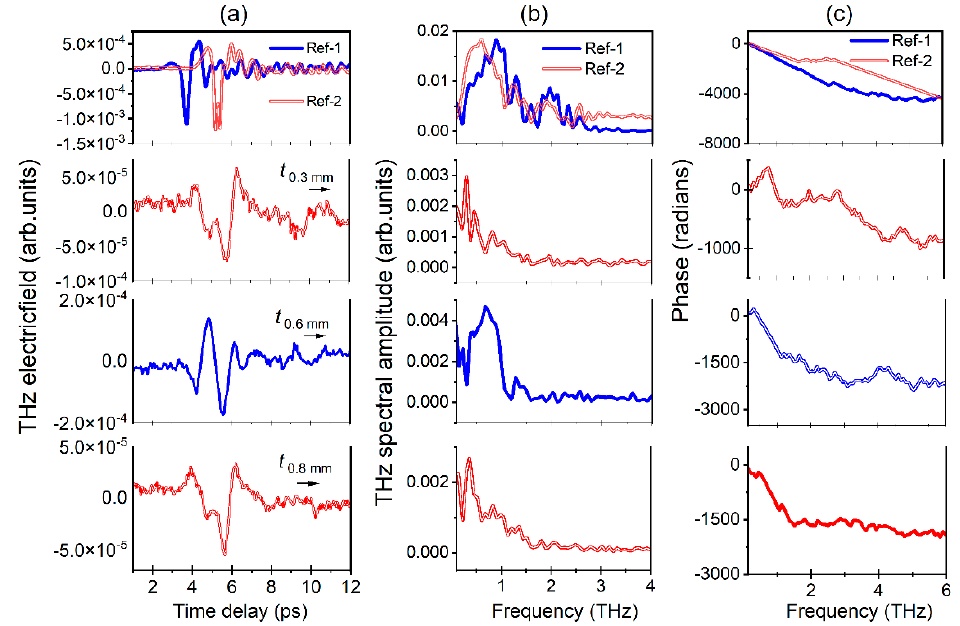
Figure 8. THz temporal profiles ( a , upper panel) of reference 1 and reference 2 measured at two different dates at BBO rotation angle 115 o ; the reference 2 pulse after transmission from MAPbBr 3 (0.3 and 0.8 mm) and reference pulse 1 transmitted from 0.6 mm MAPbBr 3 . After FFT: ( b ) spectral amplitude and ( c ) phase, respectively.